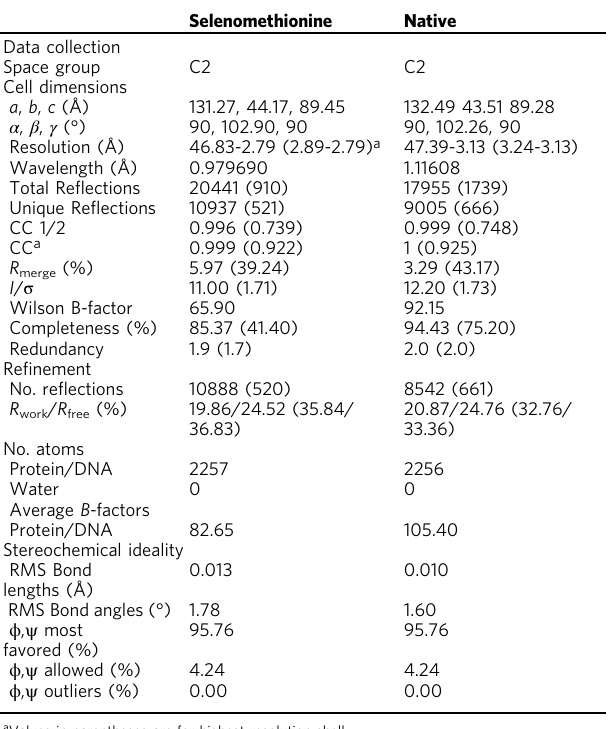
Table 1 Data collection and re fi nement statistics for the TipsytheTRex crystal